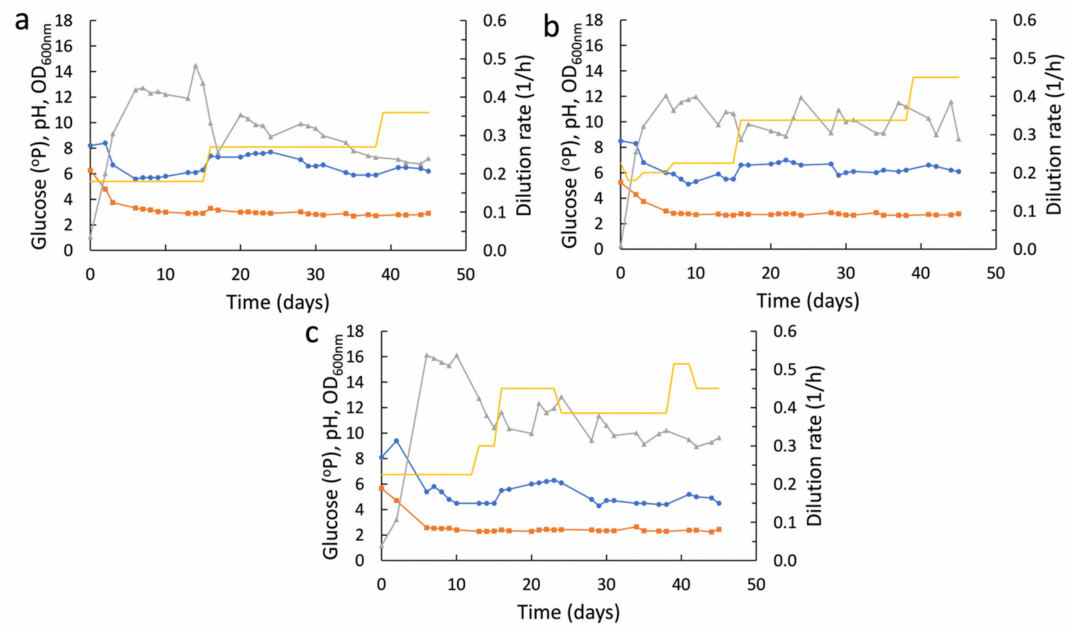
Figure 2. Cultivation of the industrial strains in the ministats: ( a ) BCD1, ( b ) BCD2, and ( c ) BCD3. Glucose content ( • ), pH ( (cid:4) ), OD 600 nm ( (cid:78) ), and the dilution rate (1 / h) ( —